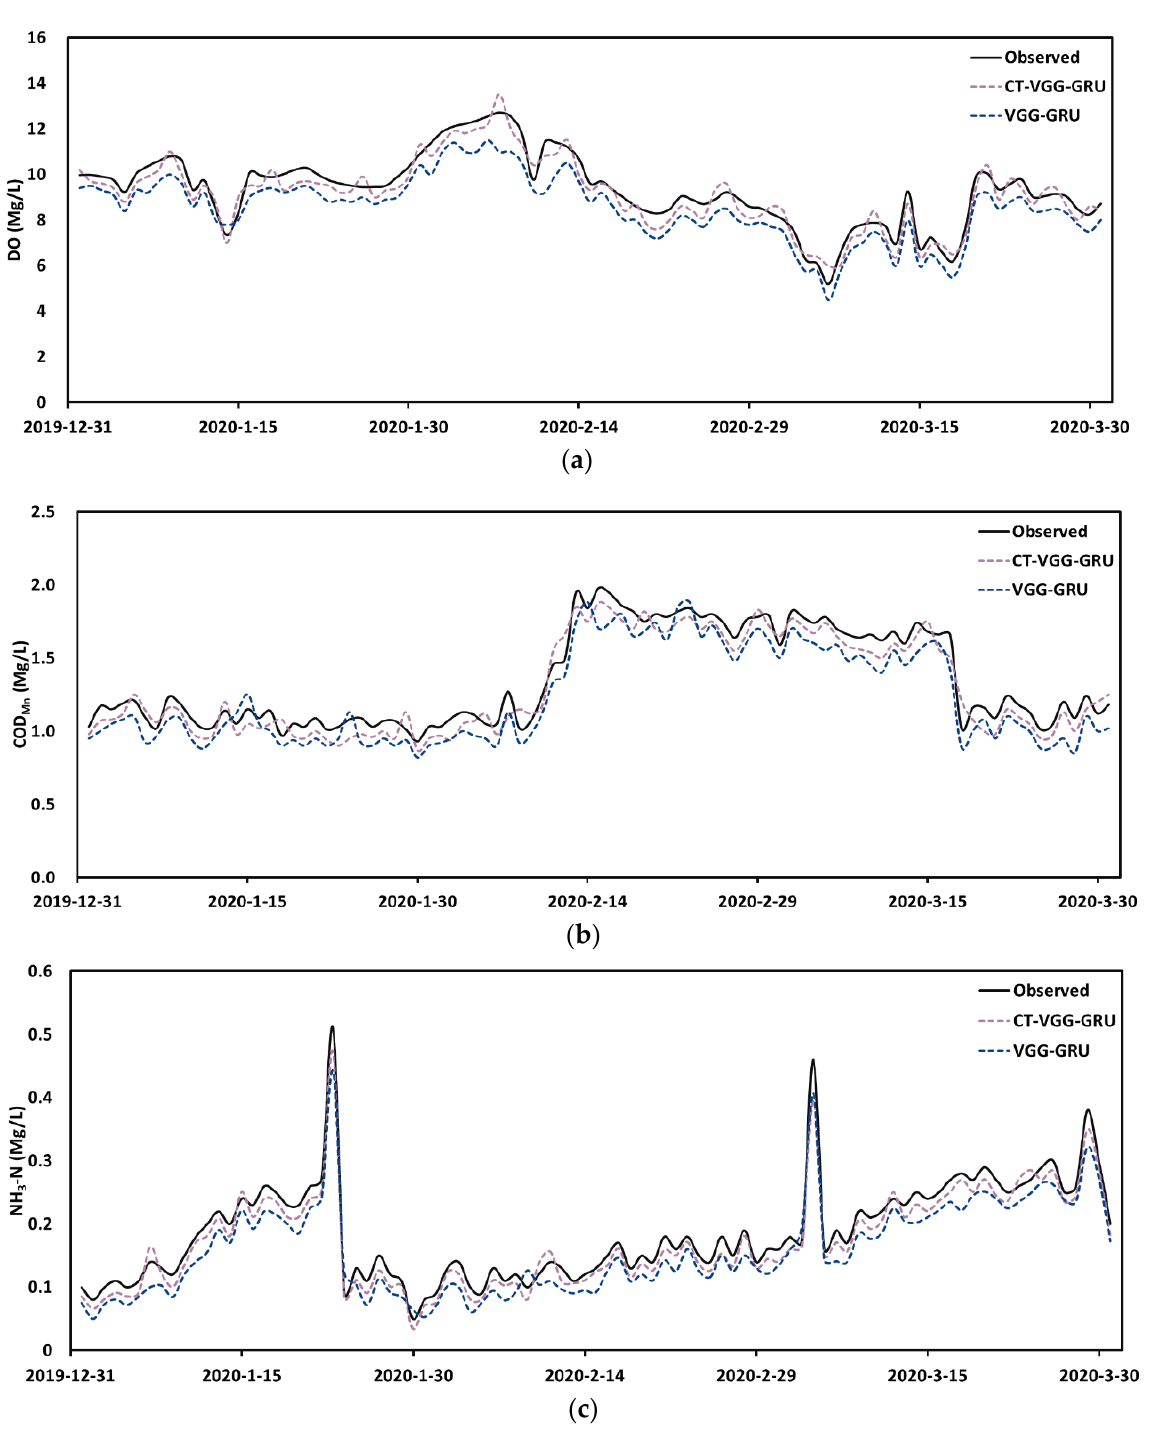
Figure 7. The predicted results of water quality indicators of the CT-VGG-GRU model and the VGG-GRU model were compared with the observed values, ( a ) DO, ( b ) COD Mn , ( c ) NH 3